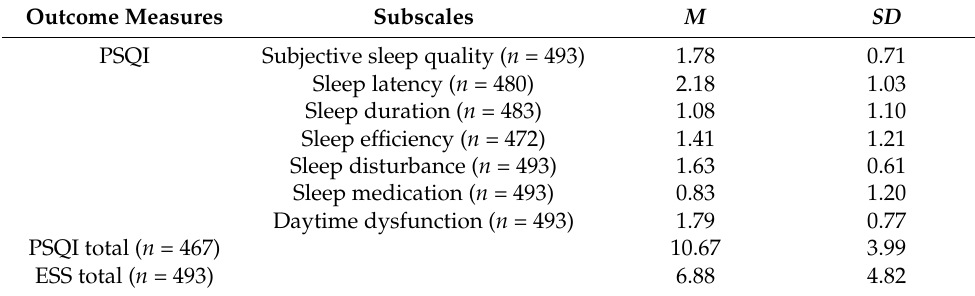
Table 2. Means and standard deviations of outcome measures and final sample size for each outcome measure. Outcome Measures Subscales M SD PSQI Subjective sleep quality ( n =